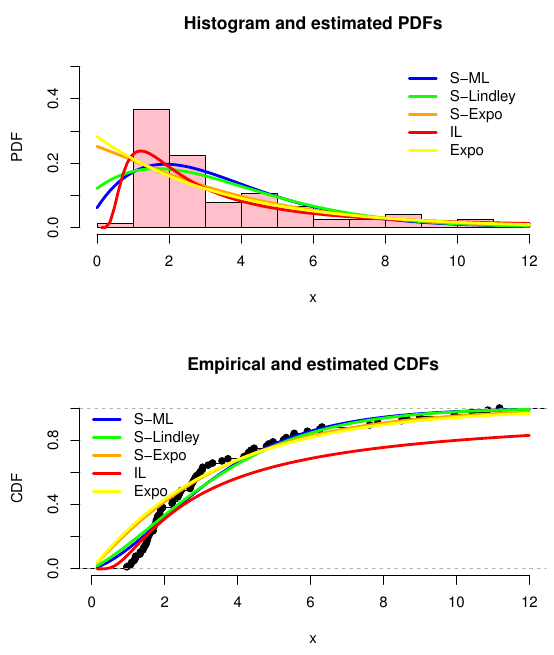
Figure 7. The EPDF and ECDF plot for the size of the tumor of the lung cancer